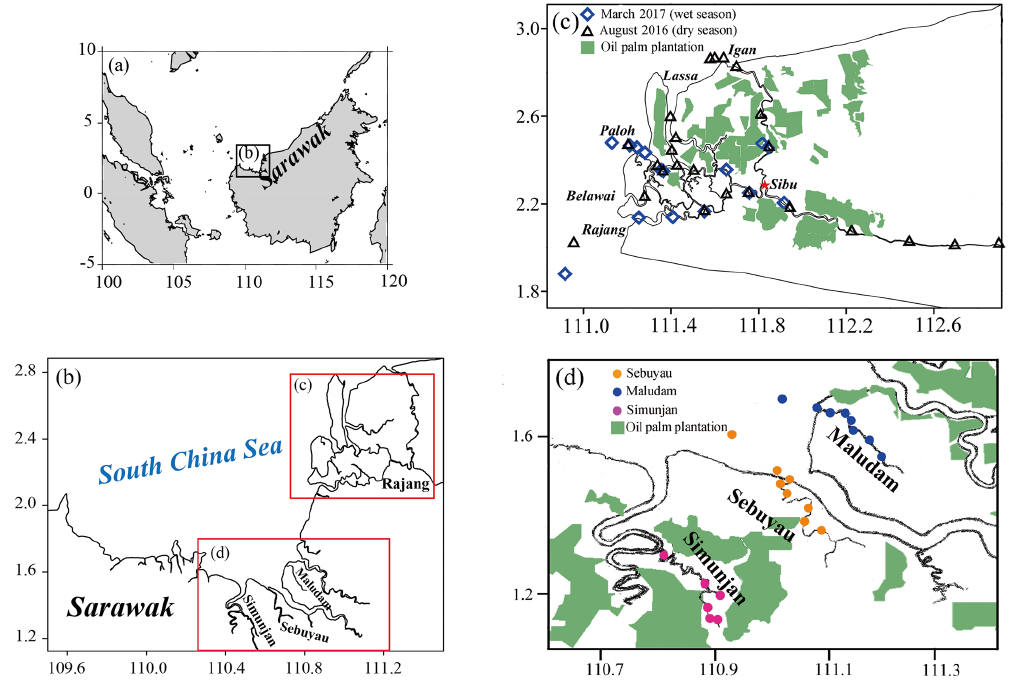
Figure 1. Distribution of sample stations in Sarawak (b) , Malaysia (a) , including Rajang in August 2016 and Rajang, Maludam, Sebuyau and Simunjan in March 2017. In (c) and (d) , the green feature layer was redrawn by the dataset from Global Forest Watch (http://gfw2-data. s3.amazonaws.com/country/mys/zip/mys_oil_palm.zip, last access: 12 January